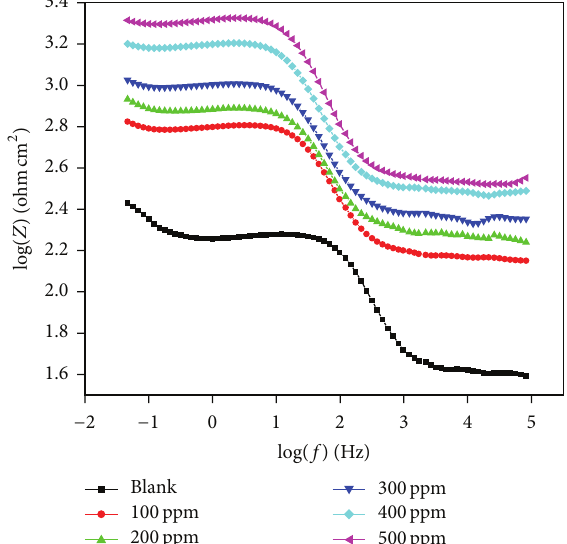
Figure 6: Bode magnitude plots for the corrosion of aluminium in 0.5 M phosphoric acid at 30 ∘ C in the presence of different concentrations of